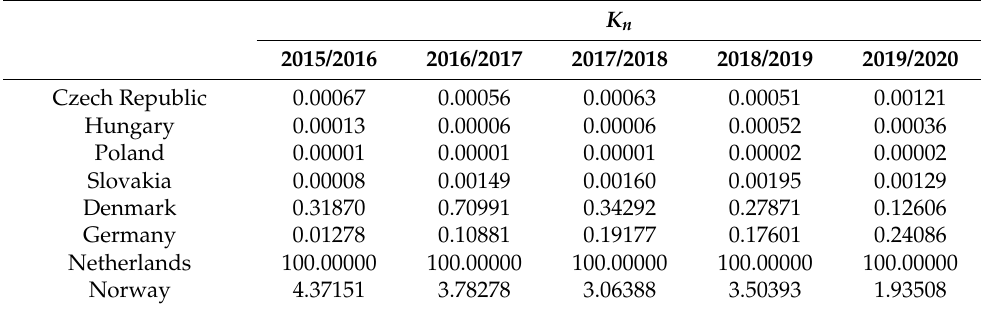
Figure 9. The progress of the infrastructural country electromobility coefficient ( K ) of V4 countries. In order to better cross-country comparison of the infrastructural country electromo- bility coefficient values, the K ’s values can be normalized. For example, it can be done in such a way that the values associated to Netherlands—the country that reach the highest K ’s values within the whole reference time period, will be changed to 100 and the values associated to other countries will be proportionally recalculated so that all the rescaled values of the parameter reduce to fit between 0 and 100. These way normalized values of the infrastructural country electromobility coefficient can be found in Table 12. Although again we have a wide range of parameter’s values, due to the normalization, the obtained K n ’s values might be possibly easier evaluated. Table 12. Normalized values of the infrastructural country electromobility coefficient ( K n ) for selected European countries at the turn of the years. K